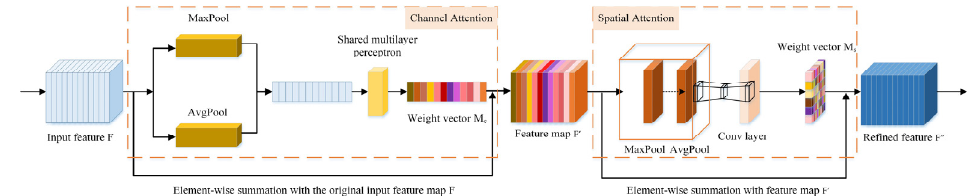
Figure 7. The structure of